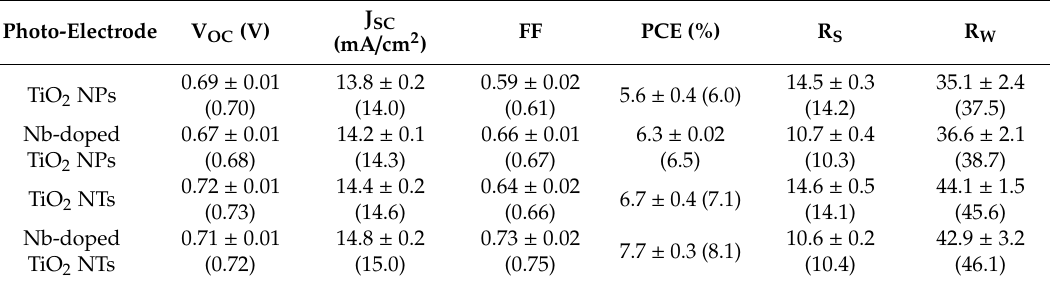
Table 1. Photovoltaic and Impedance parameters of DSCs fabricated with TiO 2 NPs- and NTs-based photoelectrodes (AM1.5G Illumination) and the series (R S ) and TiO 2 / electrolyte interface resistance (R W ) values extracted from EIS measurements. The parameters of best-performing devices are given in